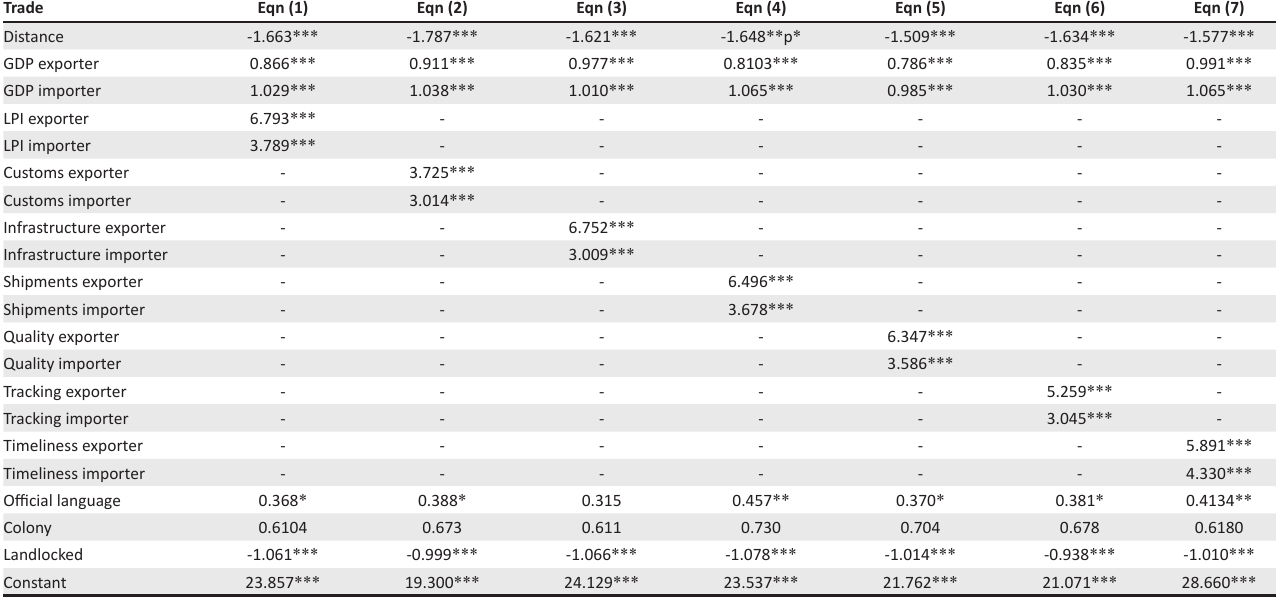
TABLE 2: Effect of logistics performance index components on export.